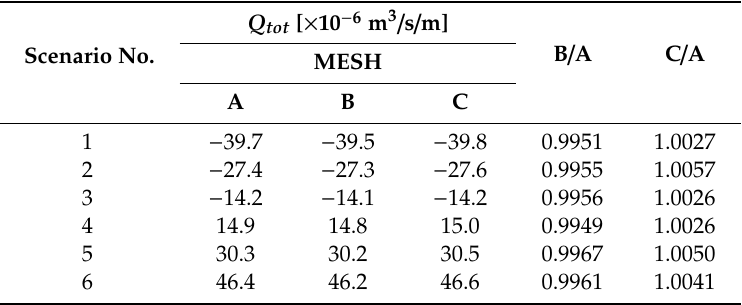
Table 2. Impact of finite element mesh size on calculated river recharge / discharge through groundwater seepage (A, 1185 nodes; B, 4564 nodes; C, 522 nodes).